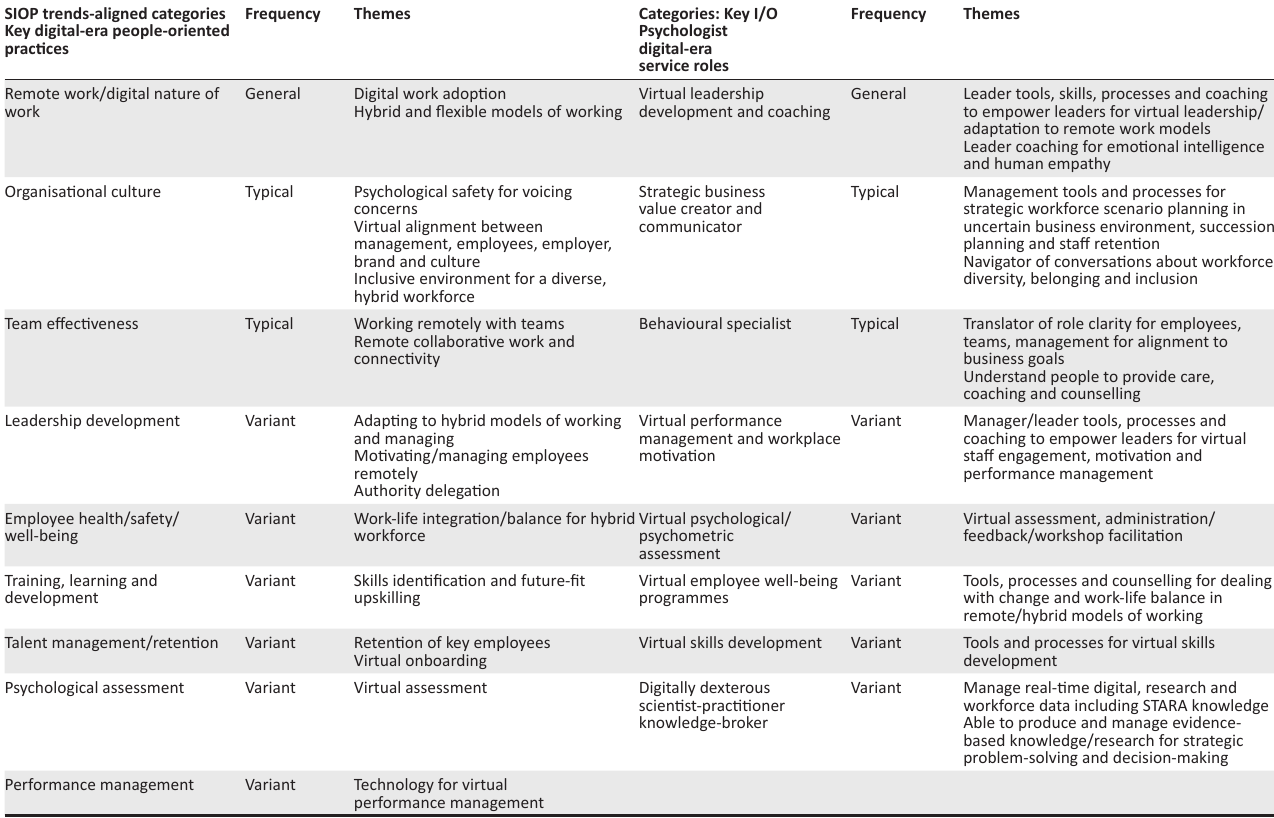
TABLE 1: Key digital-era people practices and industrial/organisational psychologist roles: Categories, frequency and themes. SIOP trends-aligned categories Key digital-era